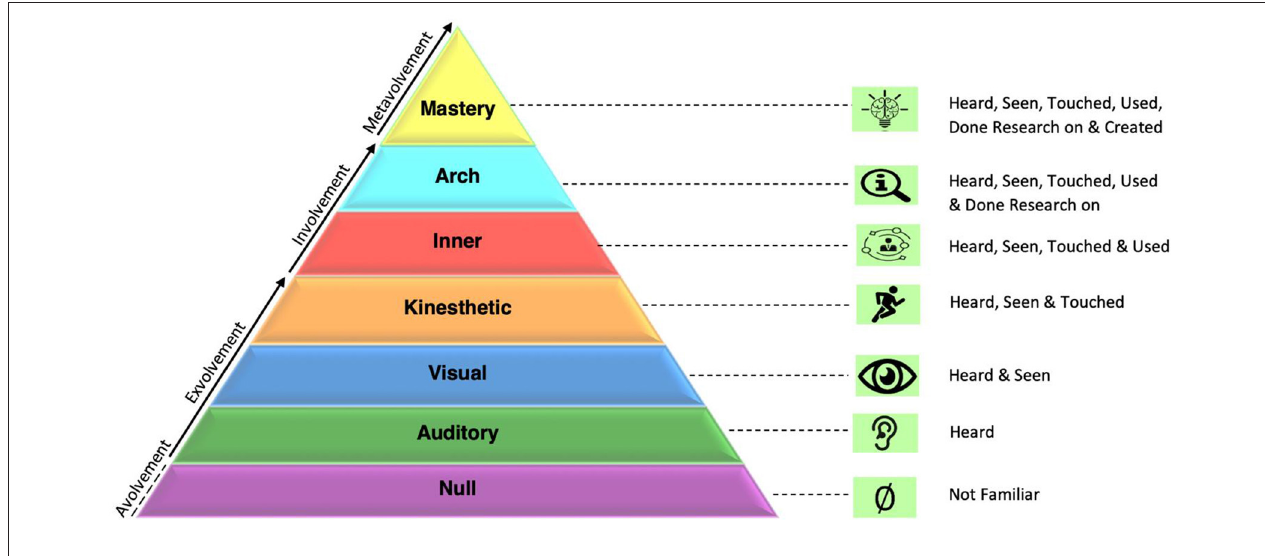
FIGURE 3 | Emotioncy pyramid.